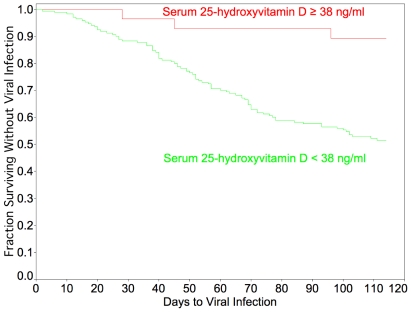
Survival without respiratory viral infection over course of study, stratified by serum 25-hydroxyvitamin D concentrations.Results of Cox proportional hazard analysis for time to viral infection, stratified by serum 25-hydroxyvitamin D concentrations. Parameters included 103 events (viral infections), 3 in the ≥38 ng/ml group and 100 in the <38 ng/ml group, and 114 censorings (15 without infection in the ≥38 ng/ml group, 99 in the <38 ng/ml group, and 3 lost to follow-up). The parameter estimate for 25-hydroxyvitamin D≥38 ng/ml was −0.66 (−1.36—0.17) 95% CI and the risk ratio 0.51 (0.25 to 0.84) 95% CI (p<0.0001).